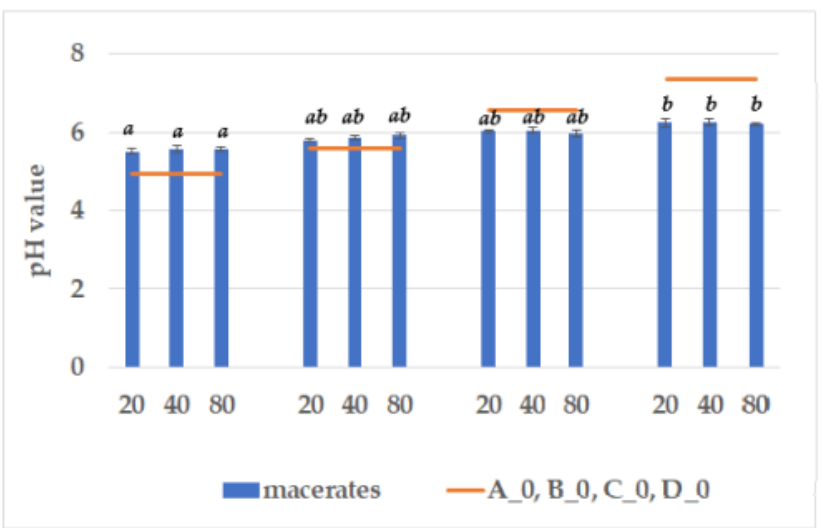
Figure 1. pH values of ethanol–water solution and mistletoe macerates prepared by maceration of 20 g/L, 40 g/L, and 80 g/L mistletoe in ethanol–water solution (A: 25%, B: 40%, C: 55%, and D: 70% v / v ethanol) at room temperature and in darkness, after 28 days of maceration. Different letters indicate significant differences between samples ( p < 0.05).